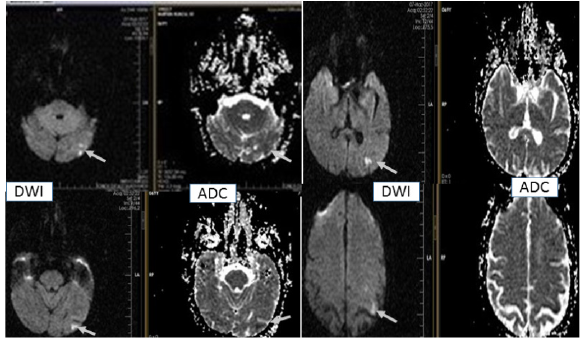
Figure 1 . Cerebral diffuse magnetic resonance showed a lesion in the left middle cerebral artery and posterior cerebral artery that was compatible with acute infarction. Abbreviations: DWI, diffusion-weighted imaging; ADC, Apparent diffusion